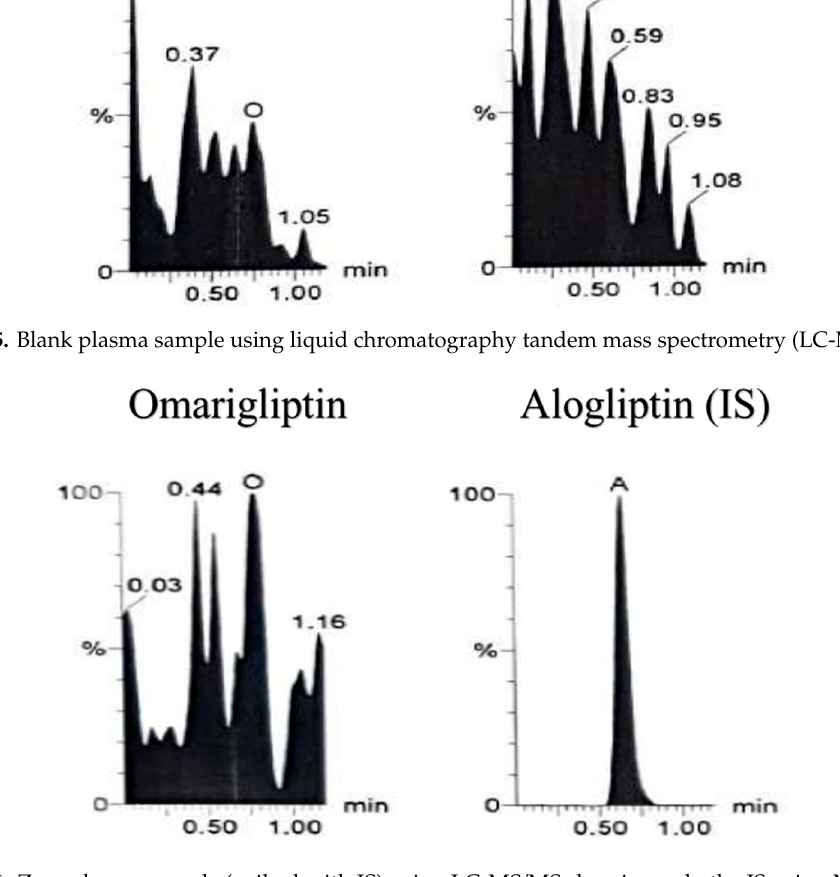
Figure 6. Zero plasma sample (spiked with IS) using LC-MS/MS showing only the IS using Multiple reaction monitoring (MRM) chromatogram of omarigliptin ( m / z = 399.2 to 153.0) and alogliptin (IS, m / z = 340.2 to 116.0).